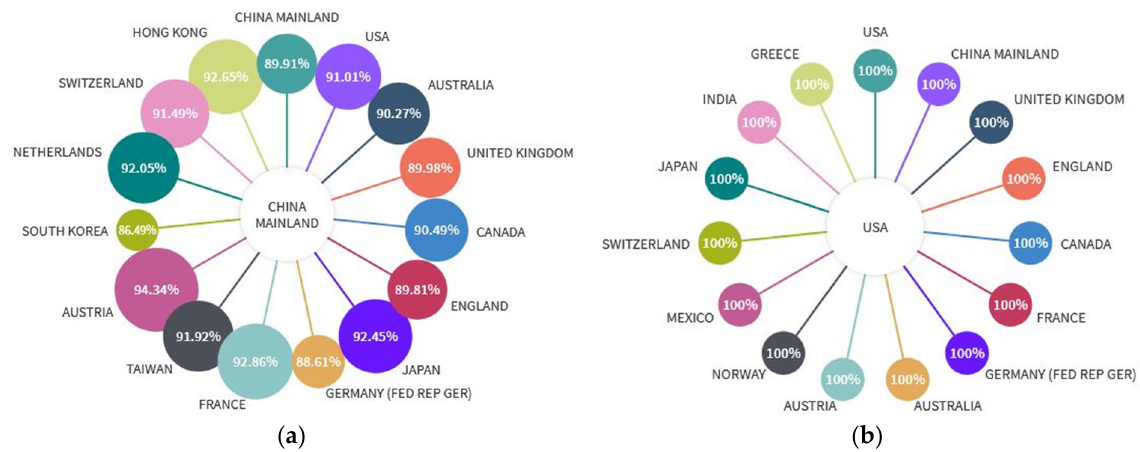
Figure 5. Percentage of cited documents in international collaboration for China ( a ) and USA ( b ).